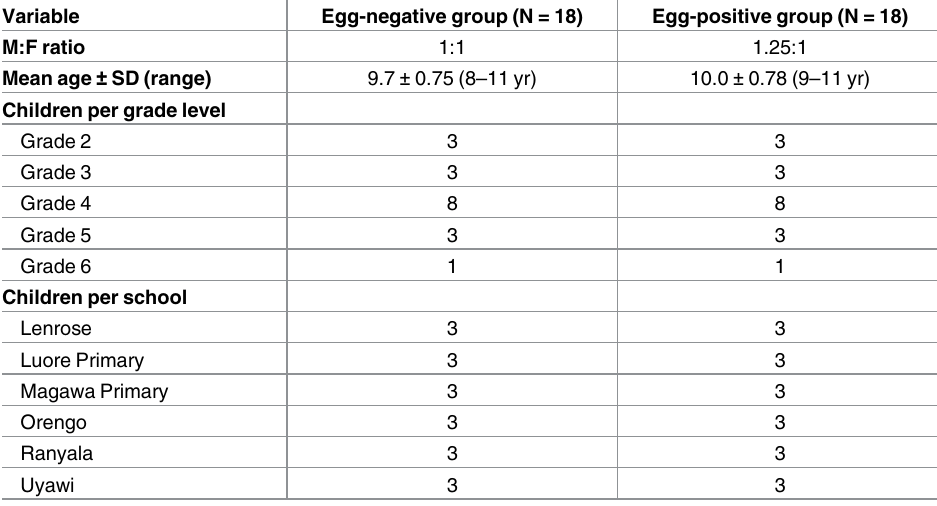
Table 1. Demographic characteristics of study